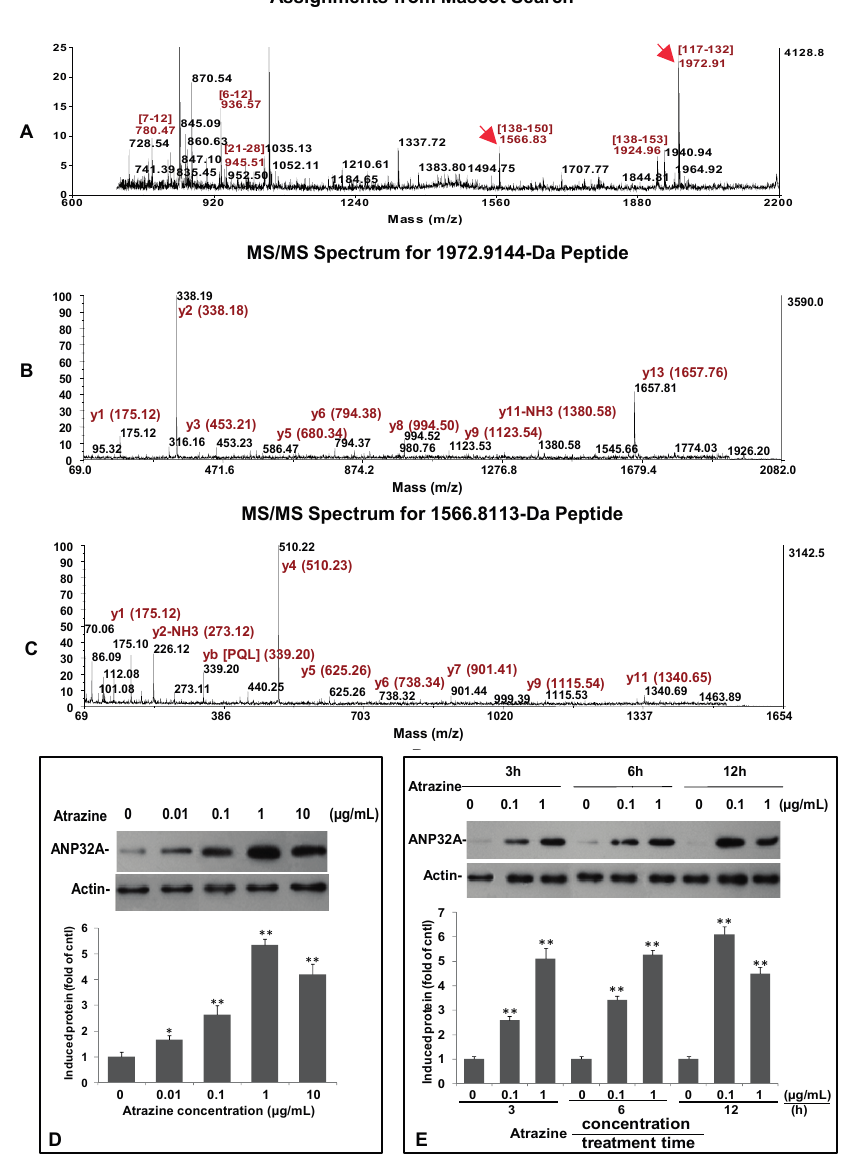
Figure 3. MS/MS and Western blot analysis of ANP32A in MCF-10A cells treated with or without atrazine for the indicated time periods. ( A ) Expanded precursor ion MS spectrum showing ANP32A tryptic peptide assignments from Mascot search. Two peptide fragments (1972.91 and 1566.83), marked with red arrow respectively, were subjected to further analysis; ( B ) MALDI TOF/TOF MS/MS spectrum for 1972.91 Da tryptic peptide (K.SLDLFNCEVTNLNDYR.E); ( C ) MALDI TOF/TOF MS/MS spectrum for 1566.81 Da tryptic peptide (K.LLPQLTYLDGYDR.E). Western blot analysis of dose ( D ) and time ( E ) responses of ANP32A to atrazine treatment. For the dose-response, cells were treated with indicated concentration of atrazine for 3 h. Western blot images in D and E are the representative images of blots and are subjected to densitometric analysis for the fold changes of ANP32A induced by atrazine in MCF-10A cells. The membrane was reprobed with an antibody to actin for comparison of equal protein load. Data = mean ± SD, * p < 0.05, ** p < 0.01 versus